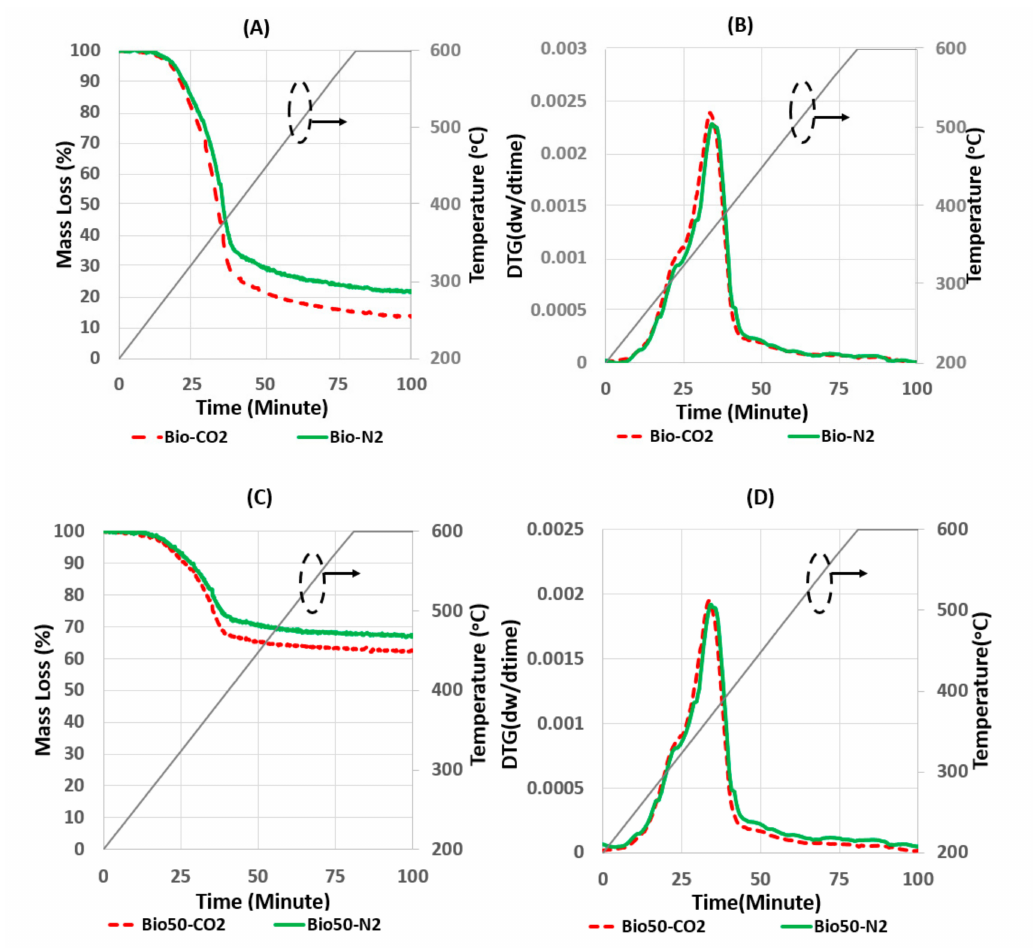
Figure 1. Thermogravimetric analysis (TGA) mass changes ( A , C ), and DTG curves ( B , D ) of Bio and Bio50. Conversion under N 2 and CO 2 at 600 ◦